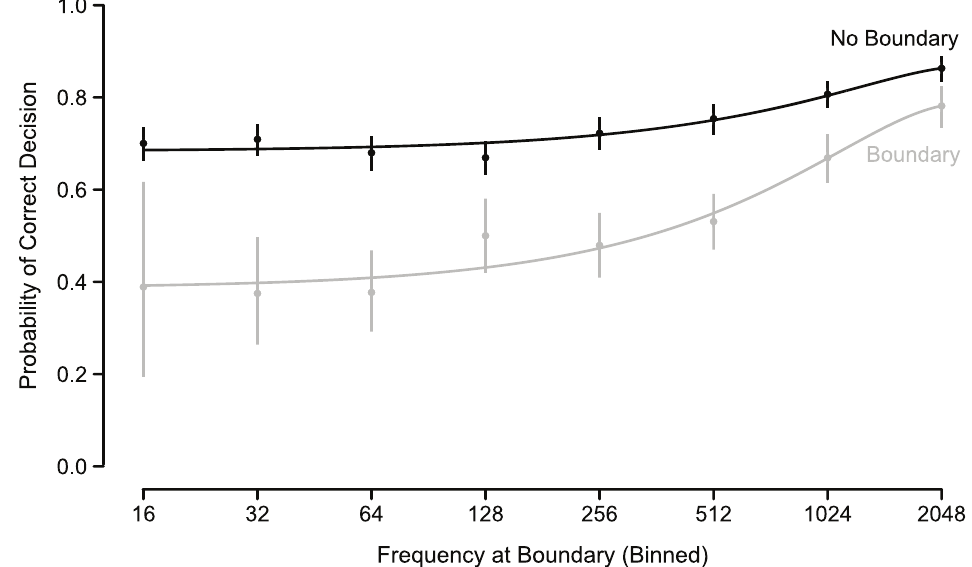
Figure 2. Probability of making a correct segmentation decision at a particular location in a sentence, plotted by whether there was a boundary at that location. Results are averaged across participants, and binned by the logarithm of the highest frequency word at the boundary (e.g., at the boundary between two words, the higher of the two word frequencies). Points show means, intervals show binomial 95% confidence intervals with a non-informative Beta prior, and lines show a loess smoother.